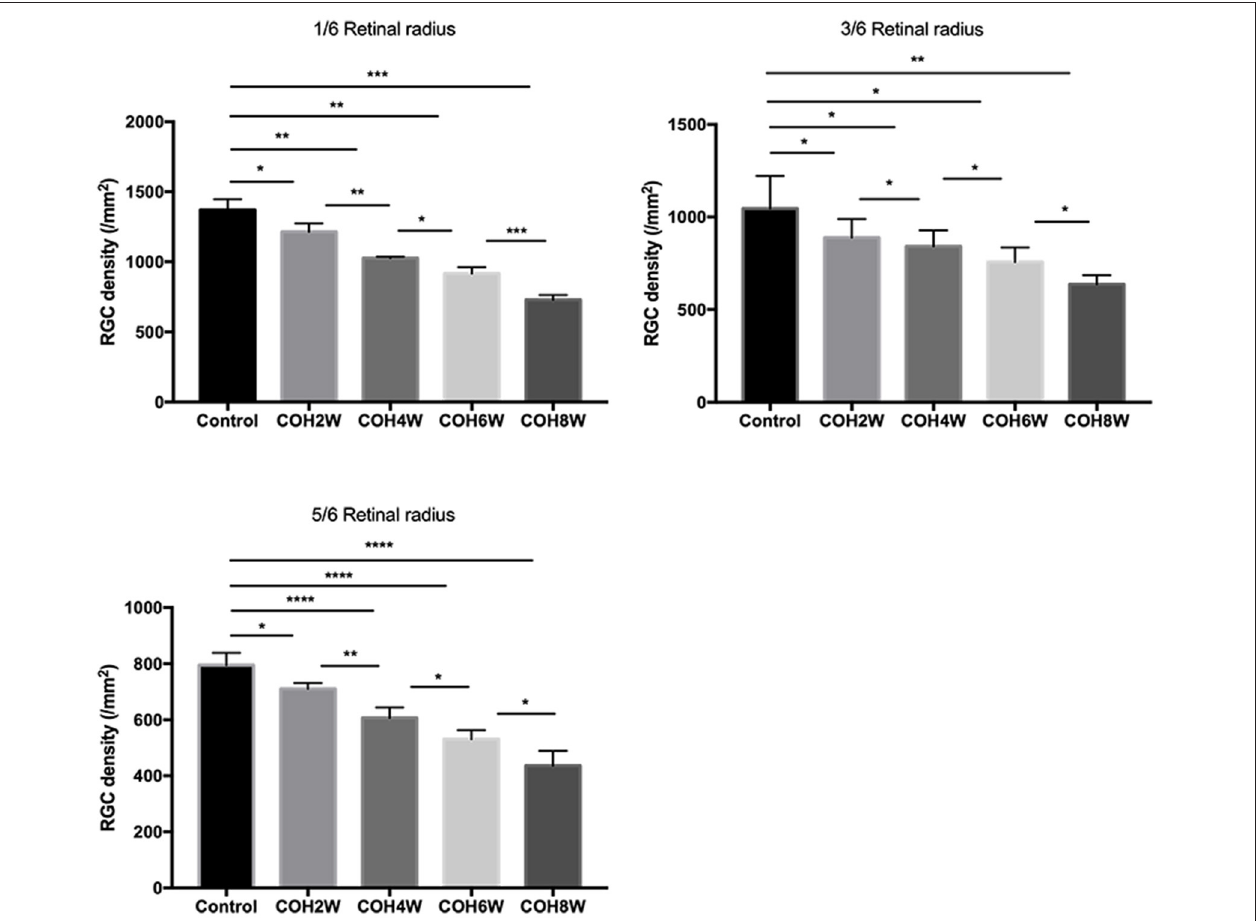
FIGURE 9 | Quantitative analysis of surviving RGCs after COH. Two, 4, 6, and 8 weeks following the induction of COH, the RGC density in 1/6, 3/6, and 5/6 retinal radius was significantly lower than that in the control group. Data were analyzed using one-way ANOVA followed by Tukey’s post hoc test (* p < 0.05, ** p < 0.01, *** p < 0.001, and **** p < 0.0001). N = 12 mice (control group: 3 mice; hydrogel injection group: 9 mice). Bars represent mean ±